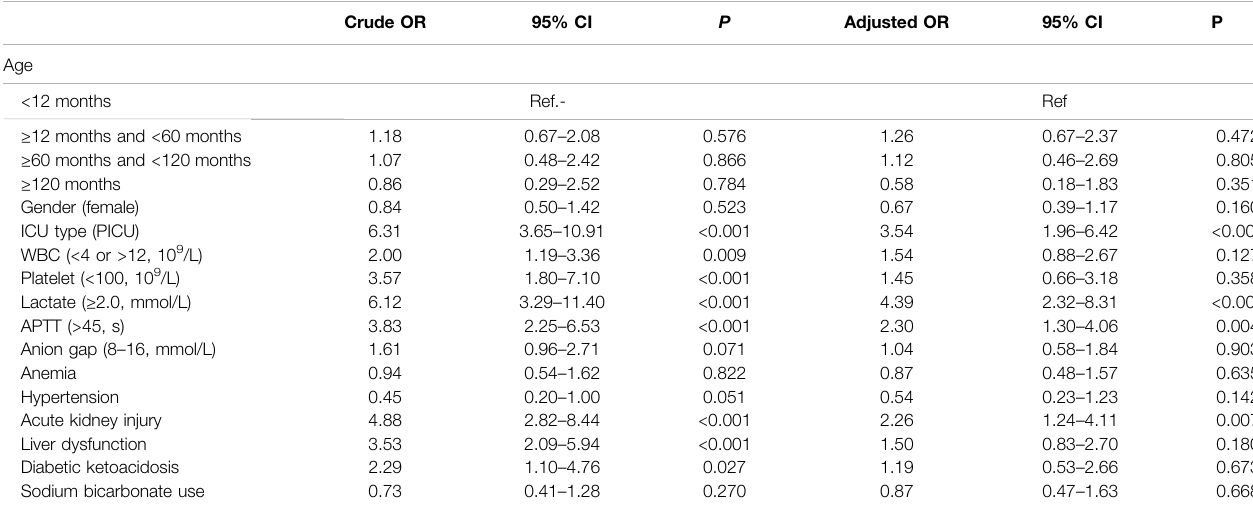
TABLE 2 | Logistic regressions of sodium bicarbonate use for in-hospital mortality. Crude OR 95% CI P Adjusted OR 95%